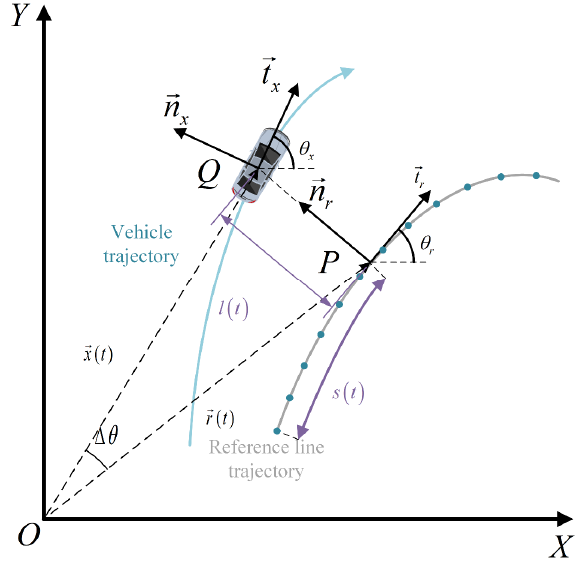
Figure 3. Schematic diagram of Frenet coordinate system and Cartesian coordinate system in normal driving state.